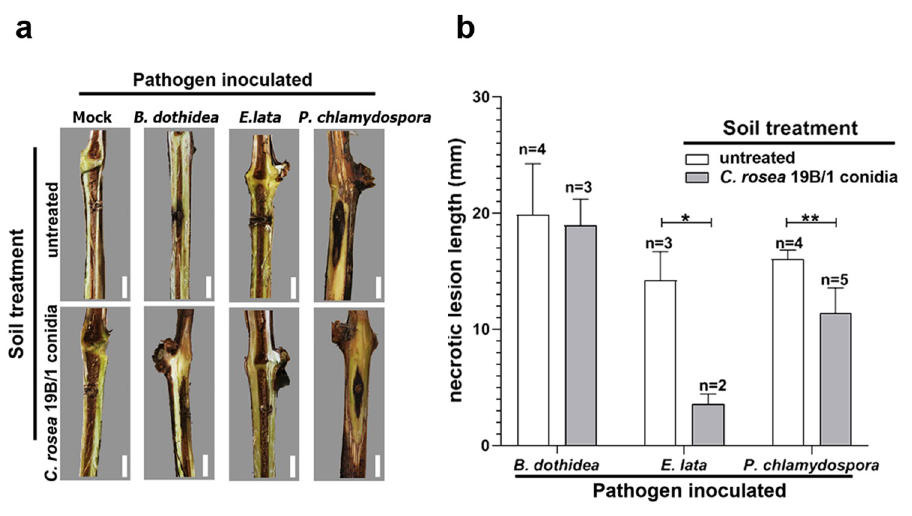
Fig 4. Effects of C . rosea 19/B1 isolate on the development of vascular necrosis caused by GTD pathogens. ( a ) Representative photographs of wood necrosis developed on Cabernet sauvignon cuttings mock inoculated or infected with B . dothidea , E . lata and P . chlamydospora . Cuttings were grown for 90 days in greenhouse in soil with (upper row) or without (bottom row) 10 4 /g conidia of C . rosea 19/B1 strain. Scale bars represent 1 cm. ( b ) Mean lengths and standard deviances of necrotic lesions developed on infected cuttings grown in the untreated or C . rosea -amended soils. Numbers above the columns represent the number of symptomatic plants out of five infected cuttings. Asterisks mark significance of differences ( � p < 0.05, �� p <